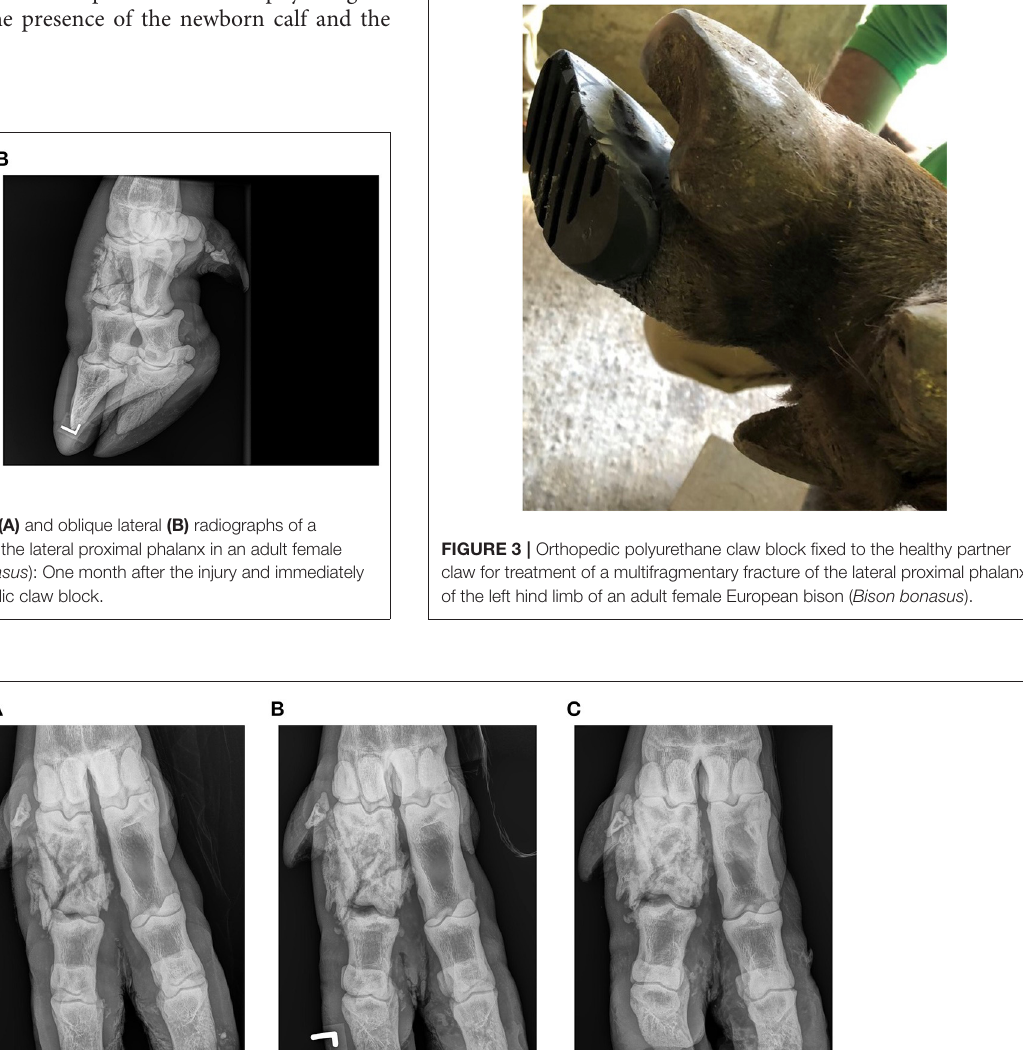
Frontiers in Veterinary Science |